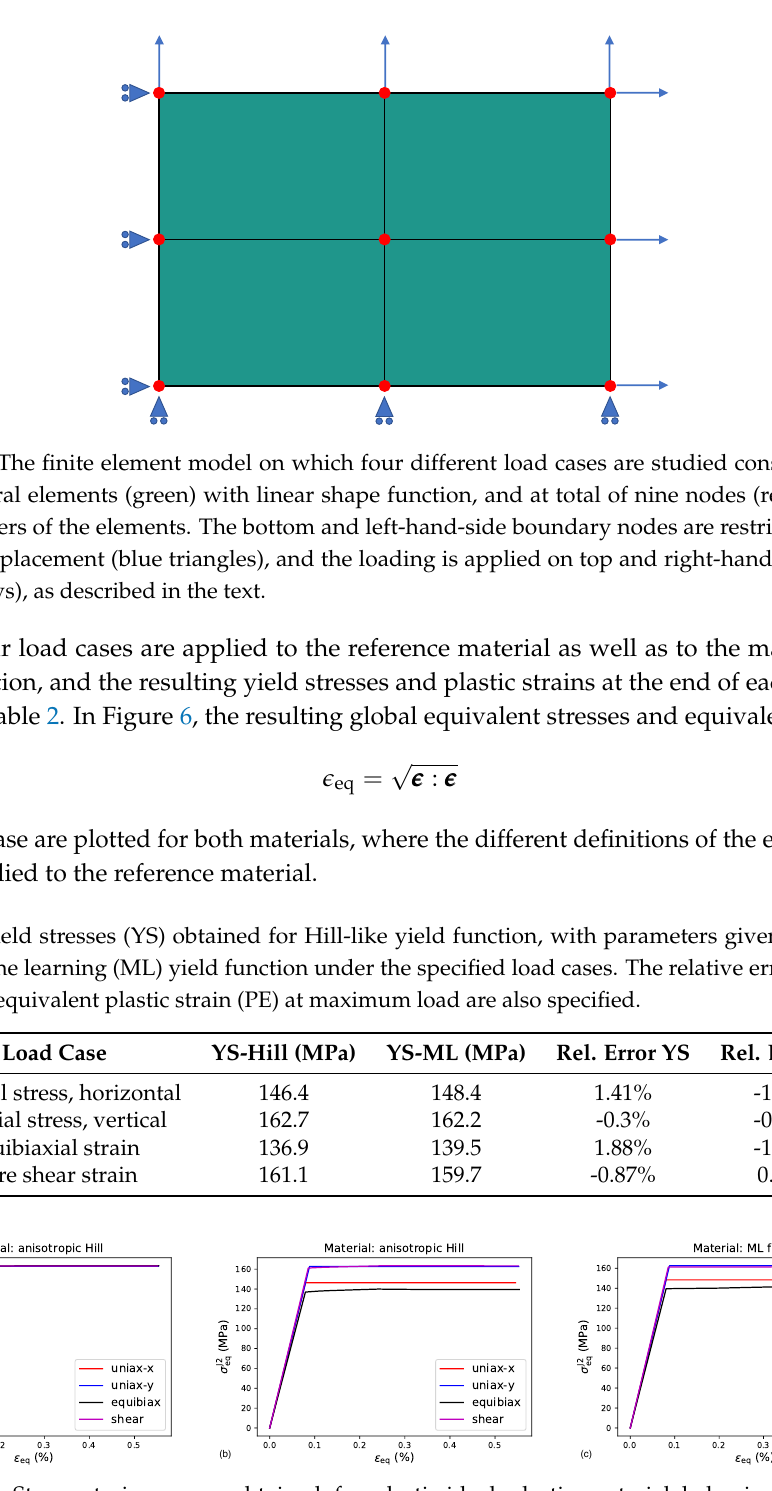
Figure 6. Stress strain curves obtained for elastic-ideal plastic material behavior under the loading conditions specified in the legend: ( a ) Equivalent total strain vs. equivalent Hill-stress, ( b ) equivalent total strain vs. equivalent J2-stress for Hill-like yield function, and ( c ) equivalent total strain vs. equivalent J2-stress for ML yield